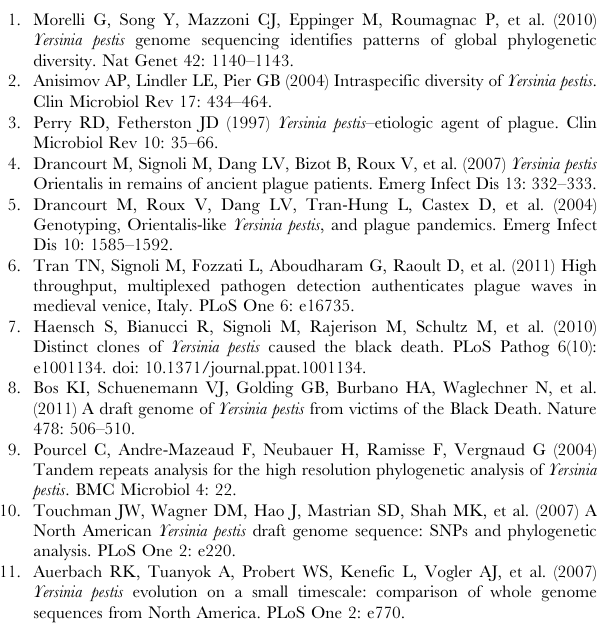
Figure S1 Representative flowgrams showing signifi- cant mutations identified in this study. (TIFF) Figure S2 Representative consensus read analysis of small Indel mutations. (TIFF) Figure S3 Identification of a representative new IS element insertion point. (TIFF) Supporting Information File S1 Sequencing and de novo assembly statistics, templated assembly statistics using CO92 as reference, comparison of in vitro and in silico MLVA results, and supplementary methods. (DOCX) Supporting Information File S2 Excel spreadsheet de- tailing High-confidence differences identified by New- bler and derived from the HCDiffs.txt files; provided as a separate file. (XLSX) Supporting Information File S3 High-confidence struc- tural variations between CO92 and 2009 NM Isolates (Provided as separate Excel File).